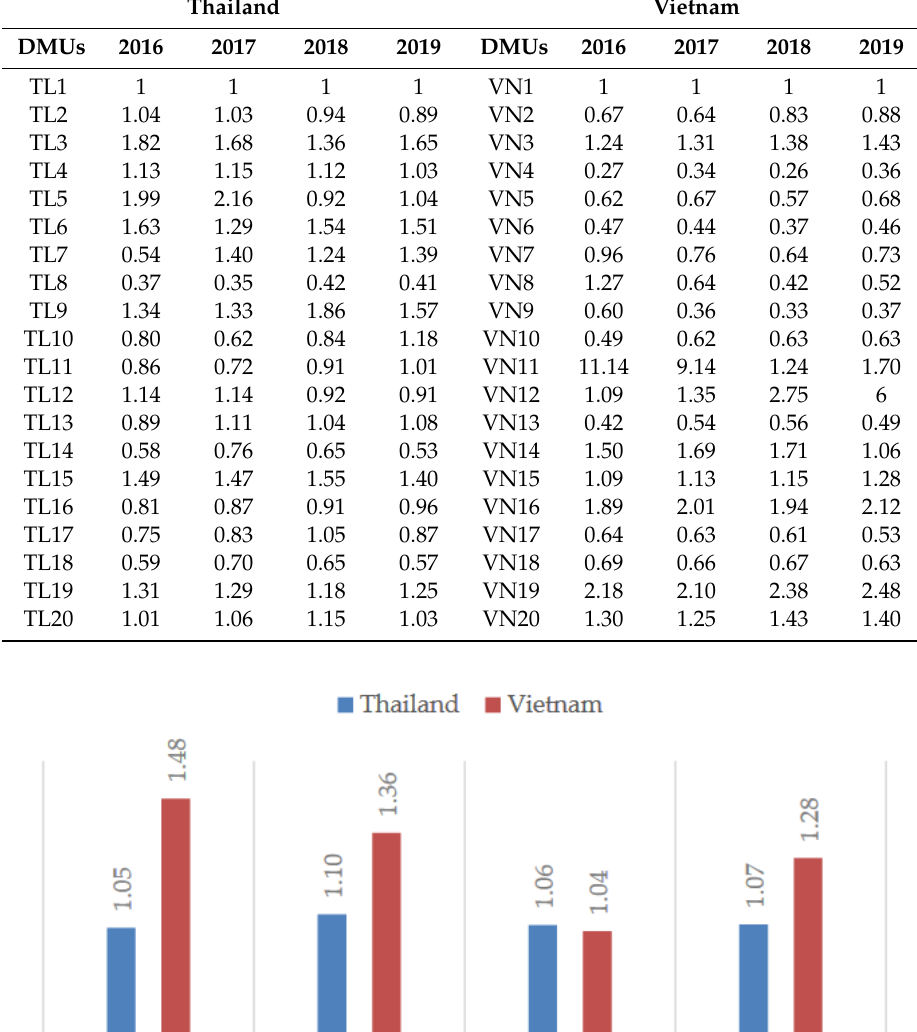
Table 4. Super slacks-based measure SBM score (2016 – 2019).